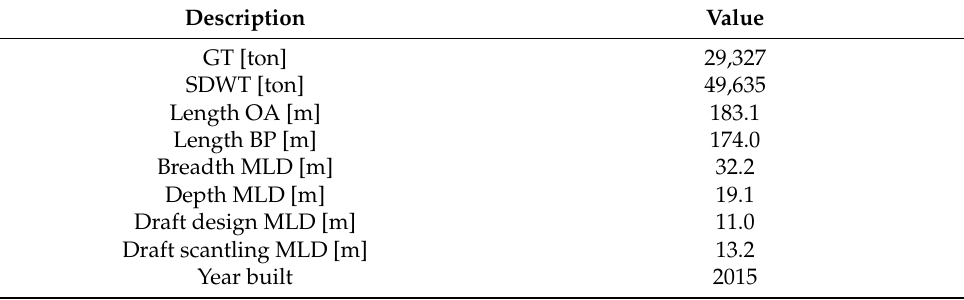
Table 1. Specifications of target ship.